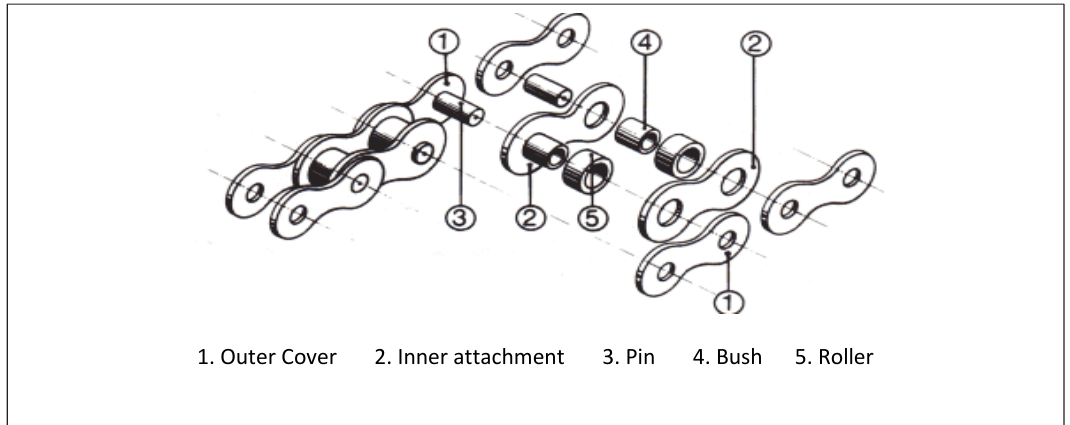
Fig. 1. Main parts of a Bicycle Chain